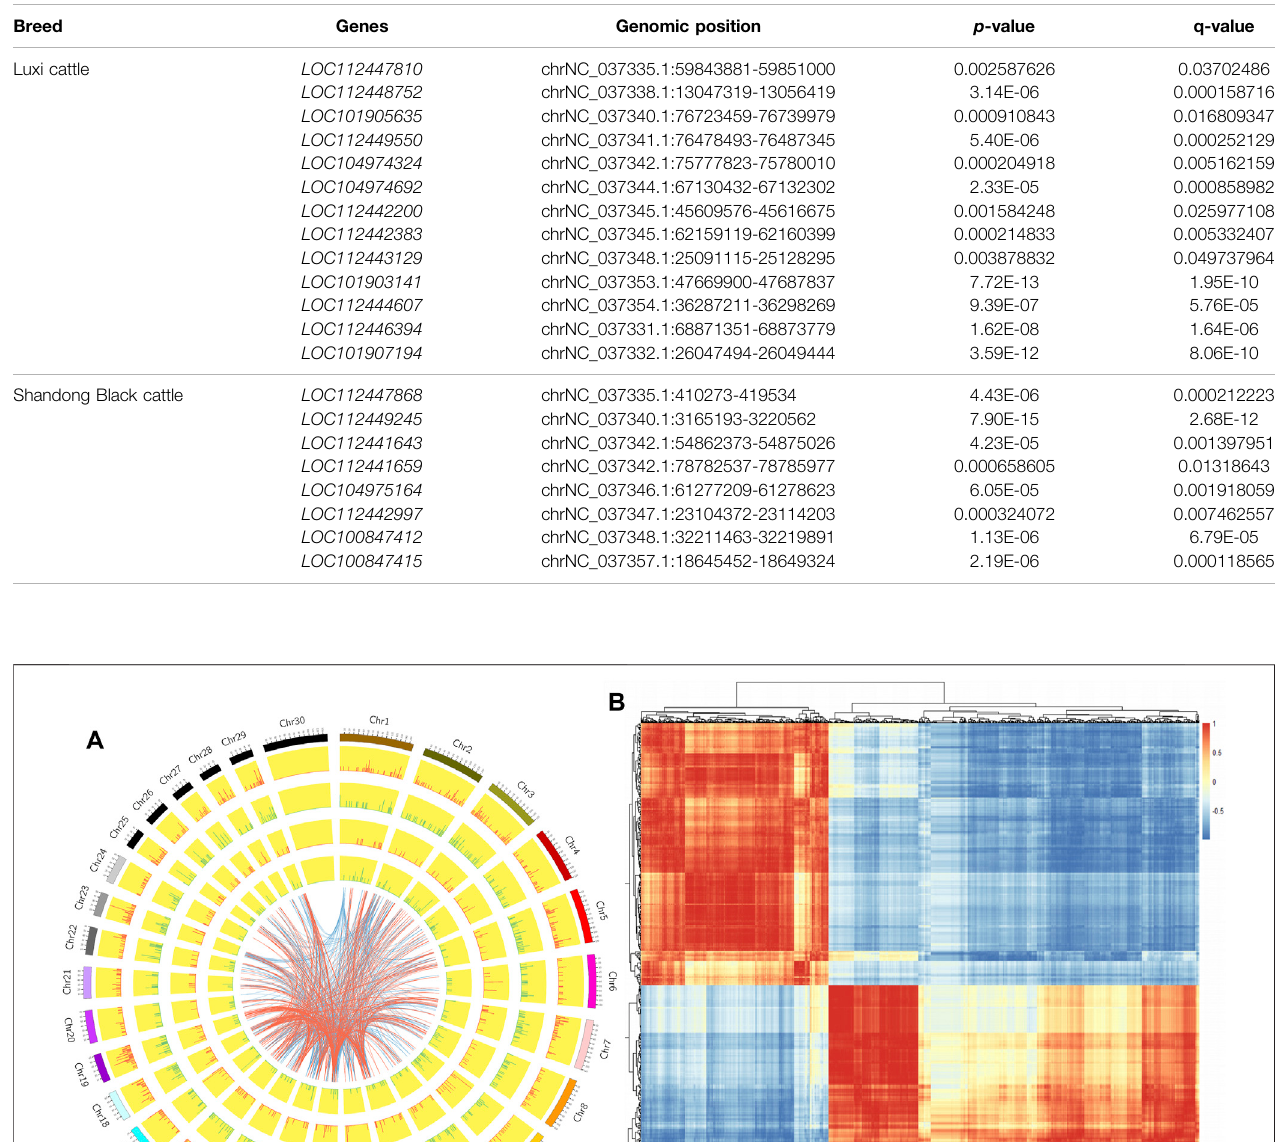
Frontiers in Genetics |